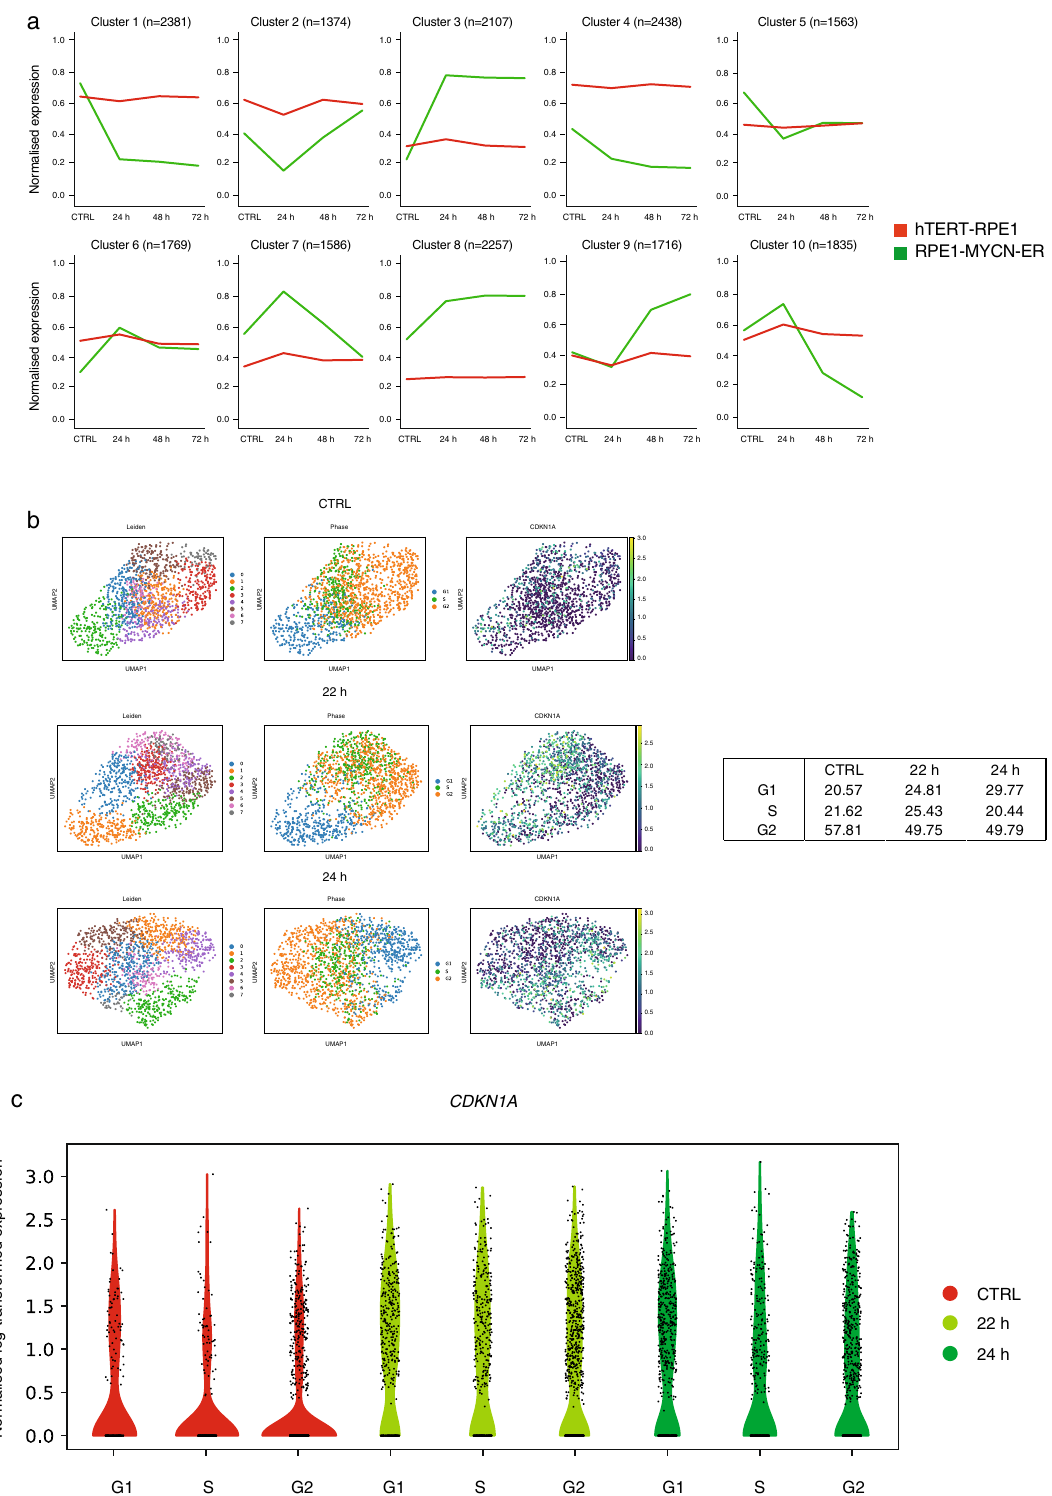
Figure 5. RNA-Sequencing indicates a heterogenous p21 response in MYCN-ON cells. ( a ) K-means clustering of all genes according to their average counts (quantile normalised) across replicates. ( b ) UMAP representation of leiden clusters, cell phase state and p21 expression in the four treatment conditions separately. The table below shows the cell phase distribution for the treatments. ( c ) Normalised log-transformed expression